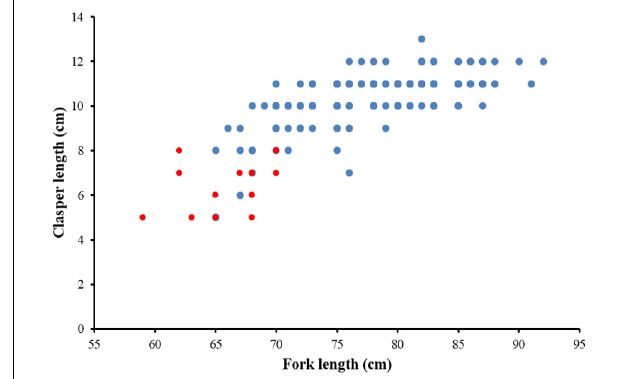
FIGURE 10 | Relationship between clasper length and fork length for P. kamoharai , from the Tropical Eastern Atlantic. Red dots represent immature males while blue dots represent mature